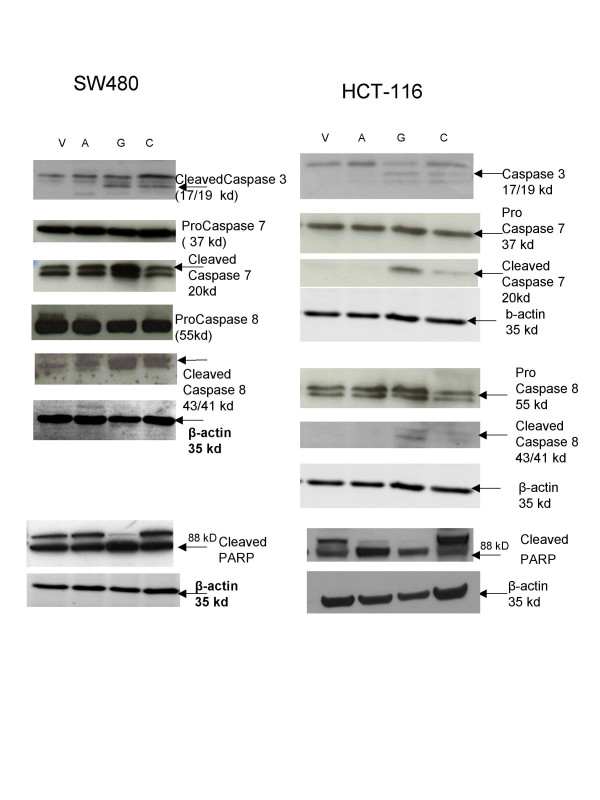
Western Blot analysis of SW480 (left) and HCT-116 (right) cell lysates following treatment with 100 μM tocopherols for 24 hours blotted with the antibodies to caspase 3, caspase 7, caspase 8, PARP, and β-actin as a loading control.